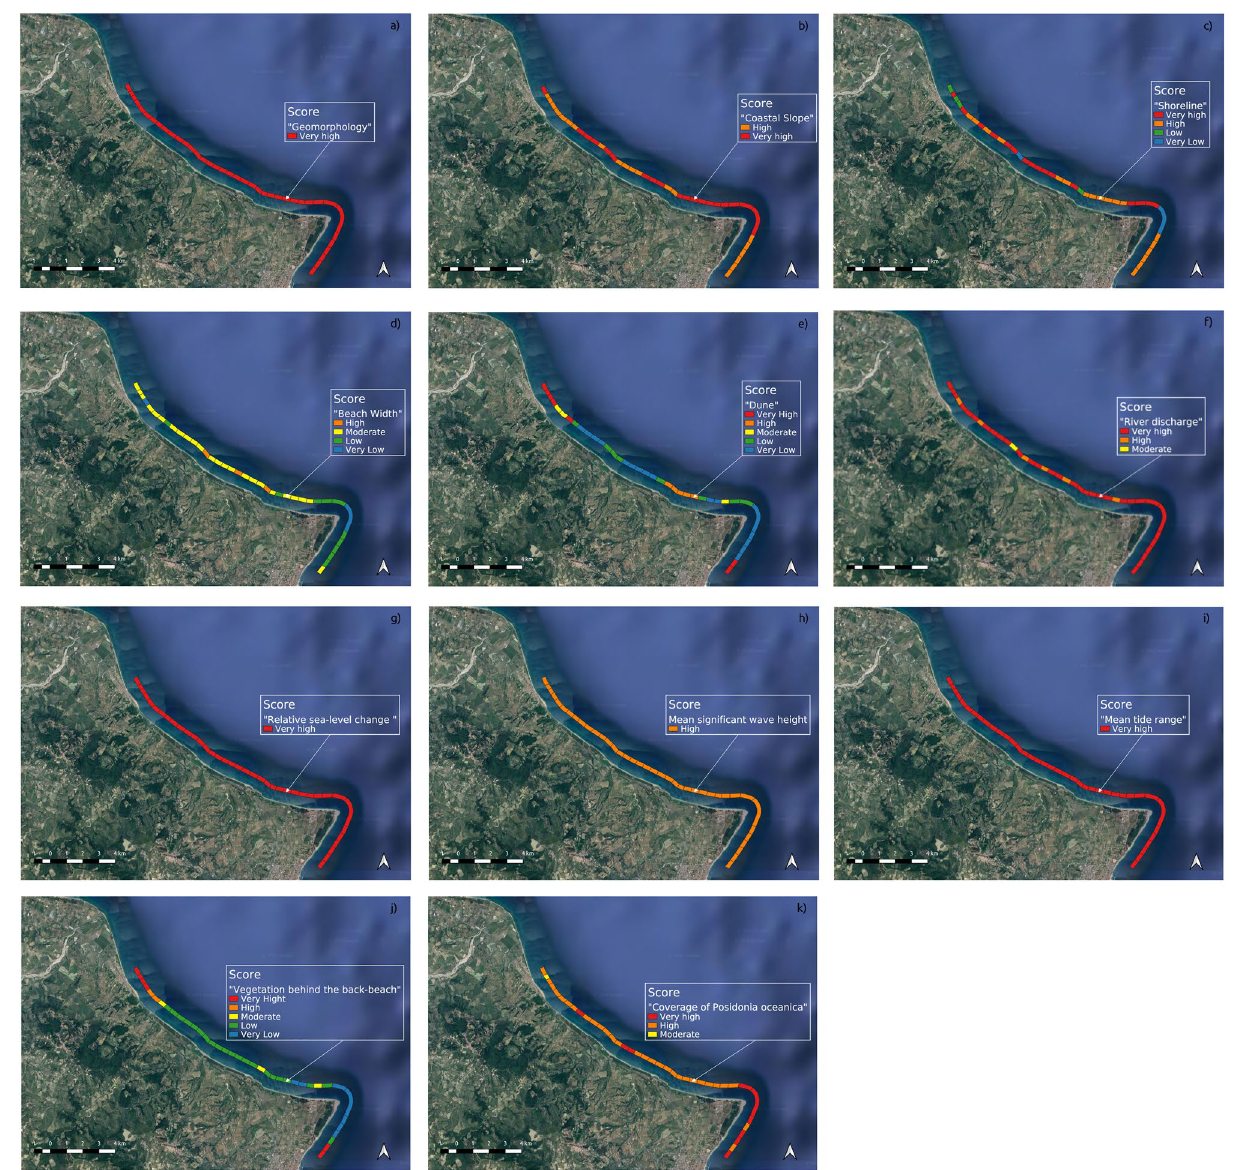
Figure 4. Score value maps for each variable: ( a ) geomorphology, ( b ) coastal slope, ( c ) shoreline erosion/ accretion rates, ( d ) emerged beach width, ( e ) dune, ( f ) river discharge, ( g ) relative sea-level change, ( h ) mean significant wave high, ( i ) mean tide range, ( j ) vegetation behind the back-beach, ( k ) coverage of Posidonia oceanica . The map was created using QGIS 3.29 software (https:// qgis. org).